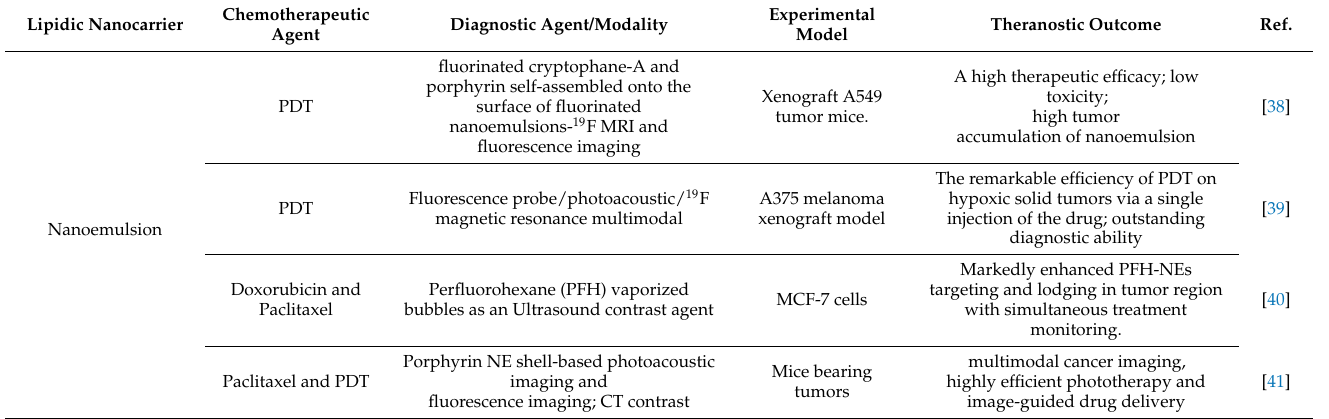
Table 1. Theranostic application of lipidic nanomedicines for cancer therapy. Lipidic Nanocarrier Chemotherapeutic